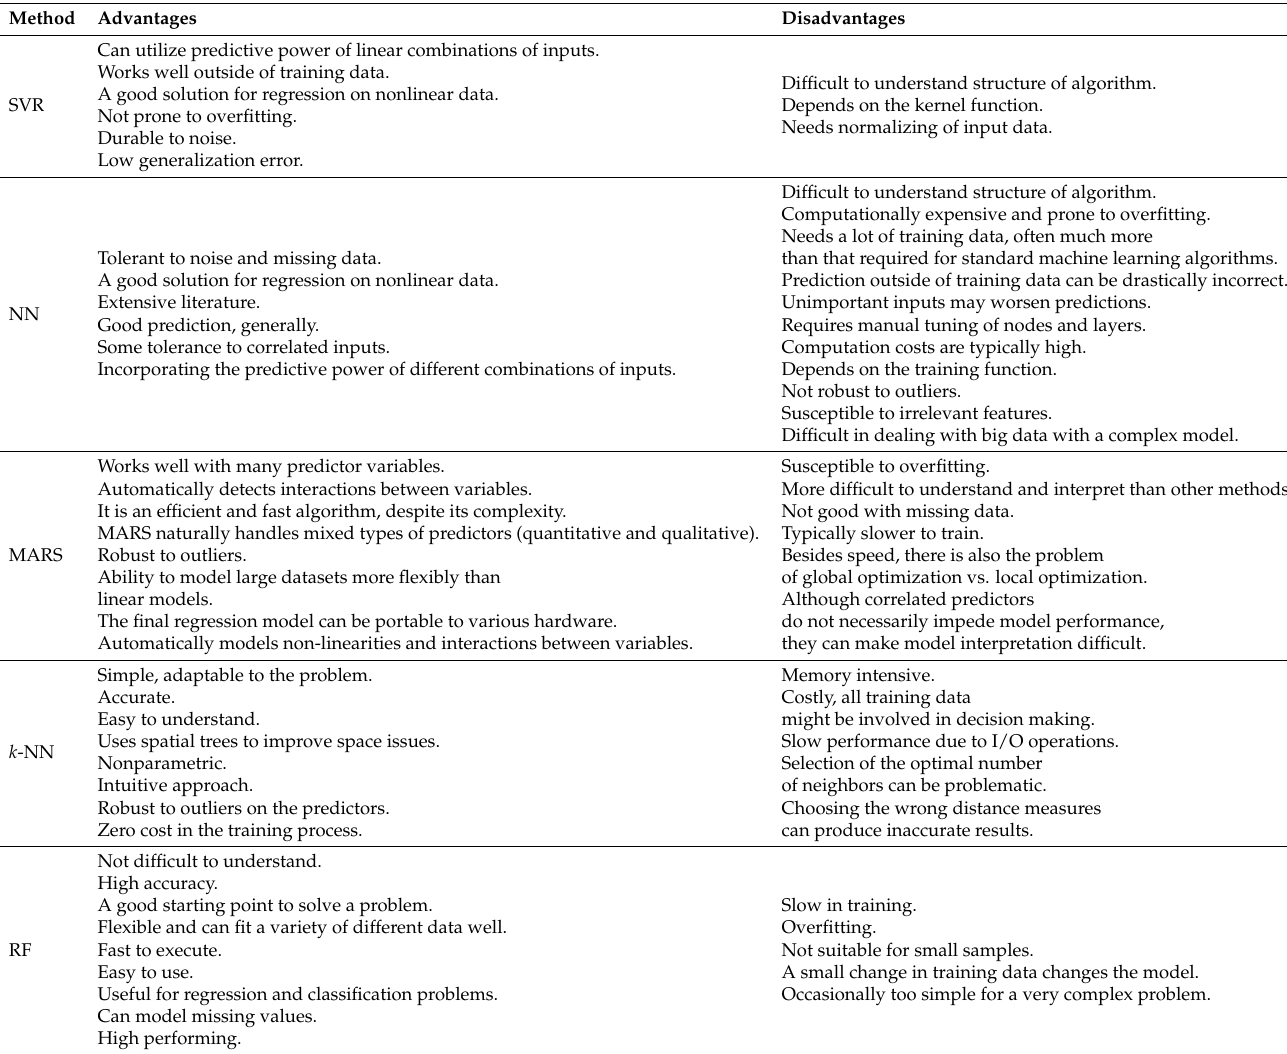
Table 3. Comparison of advantages and disadvantages of machine learning